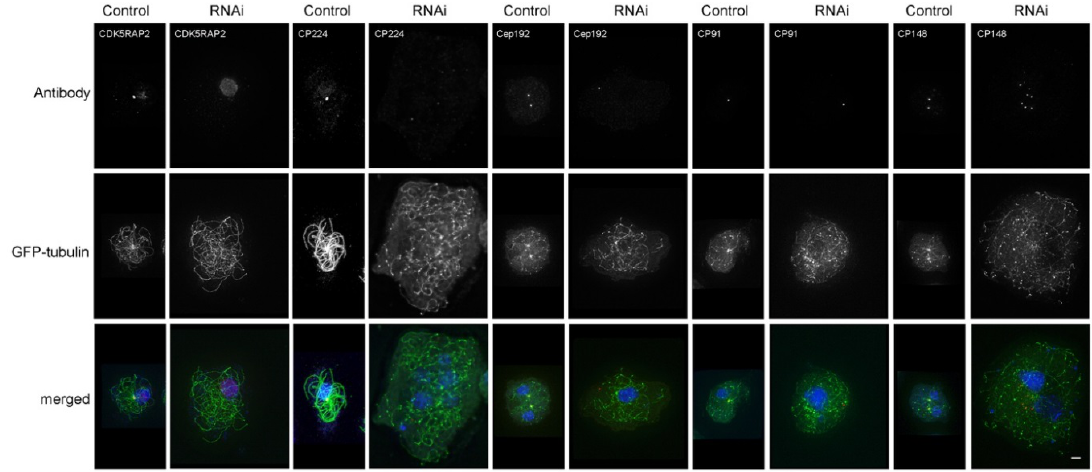
Figure 6. CDK5RAP2RNAi causes centrosome disruption. Immunofluorescence microscopy of GFP-TubA/CDK5RAP2RNAi cells stained with the indicated antibodies, in comparison to GFP- α -tubulin control cells. DNA staining with DAPI is shown in the merged images. Secondary anti-rabbit/rat/mouse antibodies were all AlexaFluor568. Cells were fixed with methanol. Maximum intensity projections of deconvolved images are displayed. Bar = 2 µm.